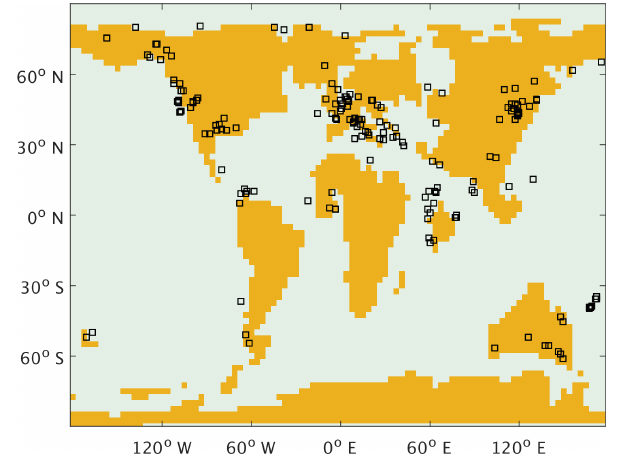
Figure 5. Locations of Eocene coal deposits plotted on our Eocene model land mask. The (cid:3) symbols indicate an Eocene coal deposit location (Boucot et al.,